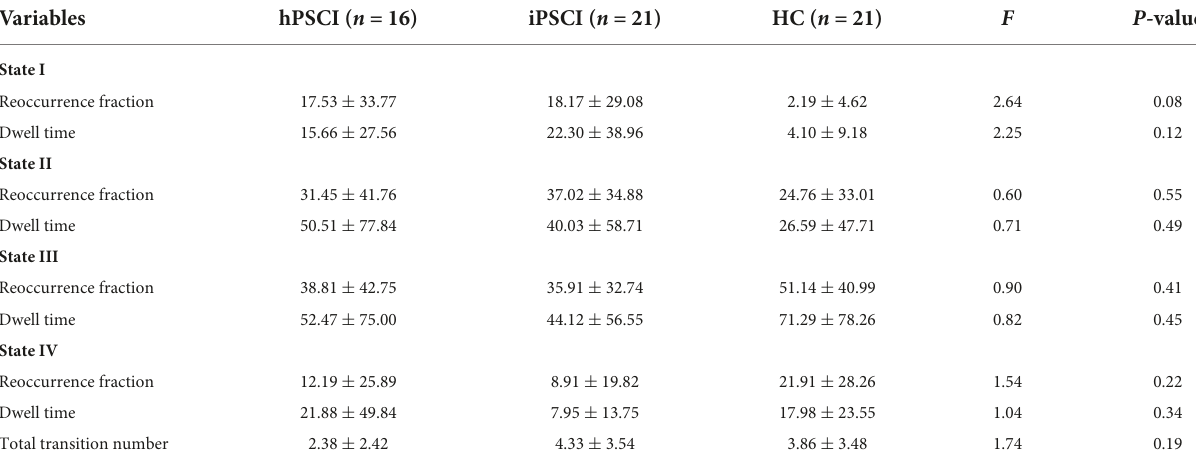
TABLE 3 The temporal properties for each state and each